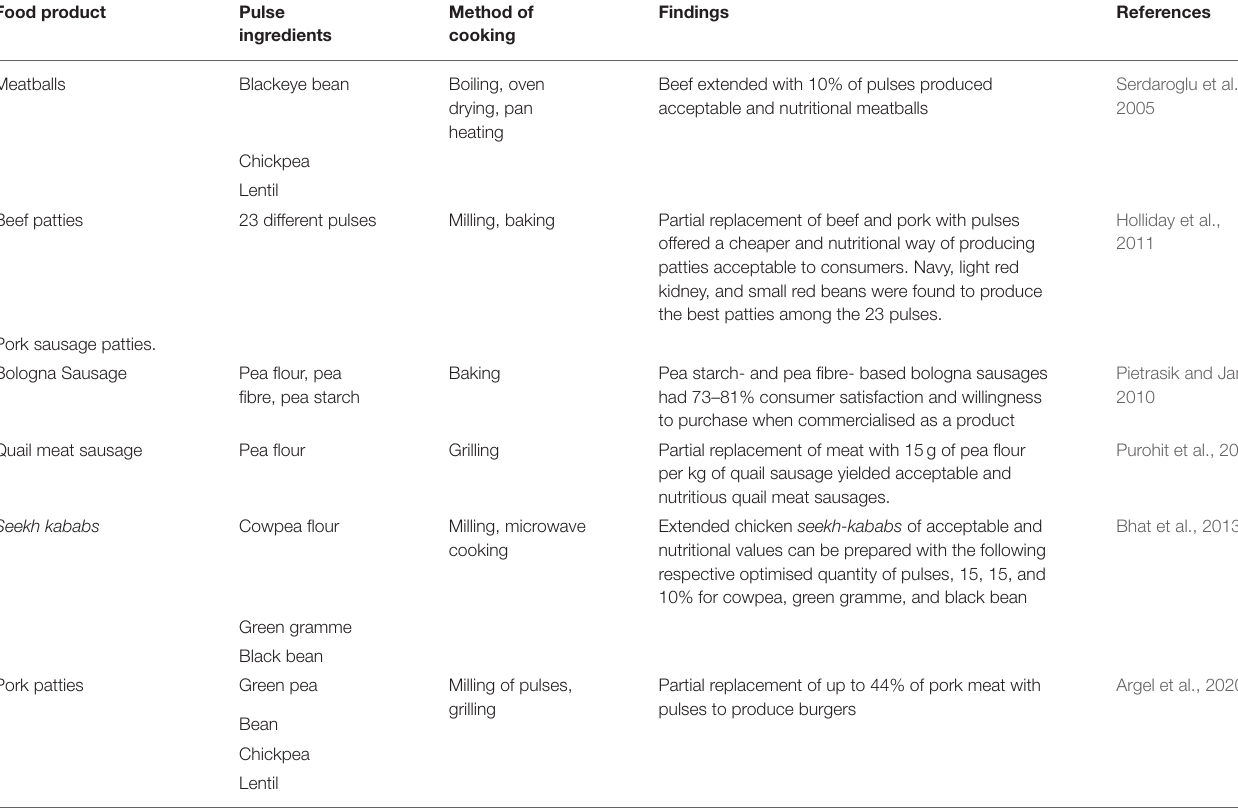
TABLE 2 | Processing of pulses to formulate sustainable pulse-based meat